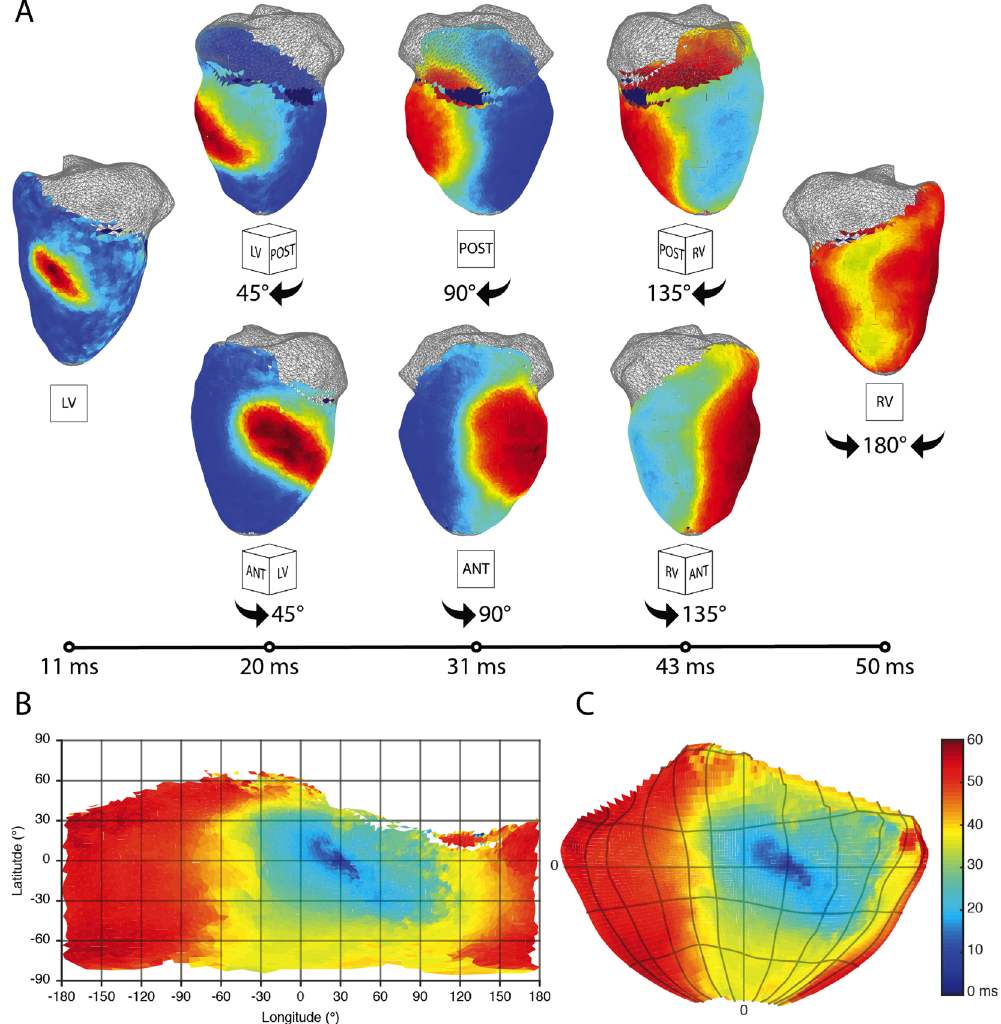
Figure 5. Activation in representative rabbit panoramic optical data. ( A ) The time course of pacing activation is tracked using membrane potential. A paced beat starts on the left ventricular free wall and the divergent wavefronts are tracked over time around both the posterior and anterior sides to where they meet on the right ventricular free wall. Wavefronts are uninterrupted by artifact or discontinuity. ( B ) On the left, a 2D Mercator projection of the isochronal activation map generated using the processing GUI. On the right, a 2D Hammer projection whose latitude and longitude divisions are the same as seen in the Mercator